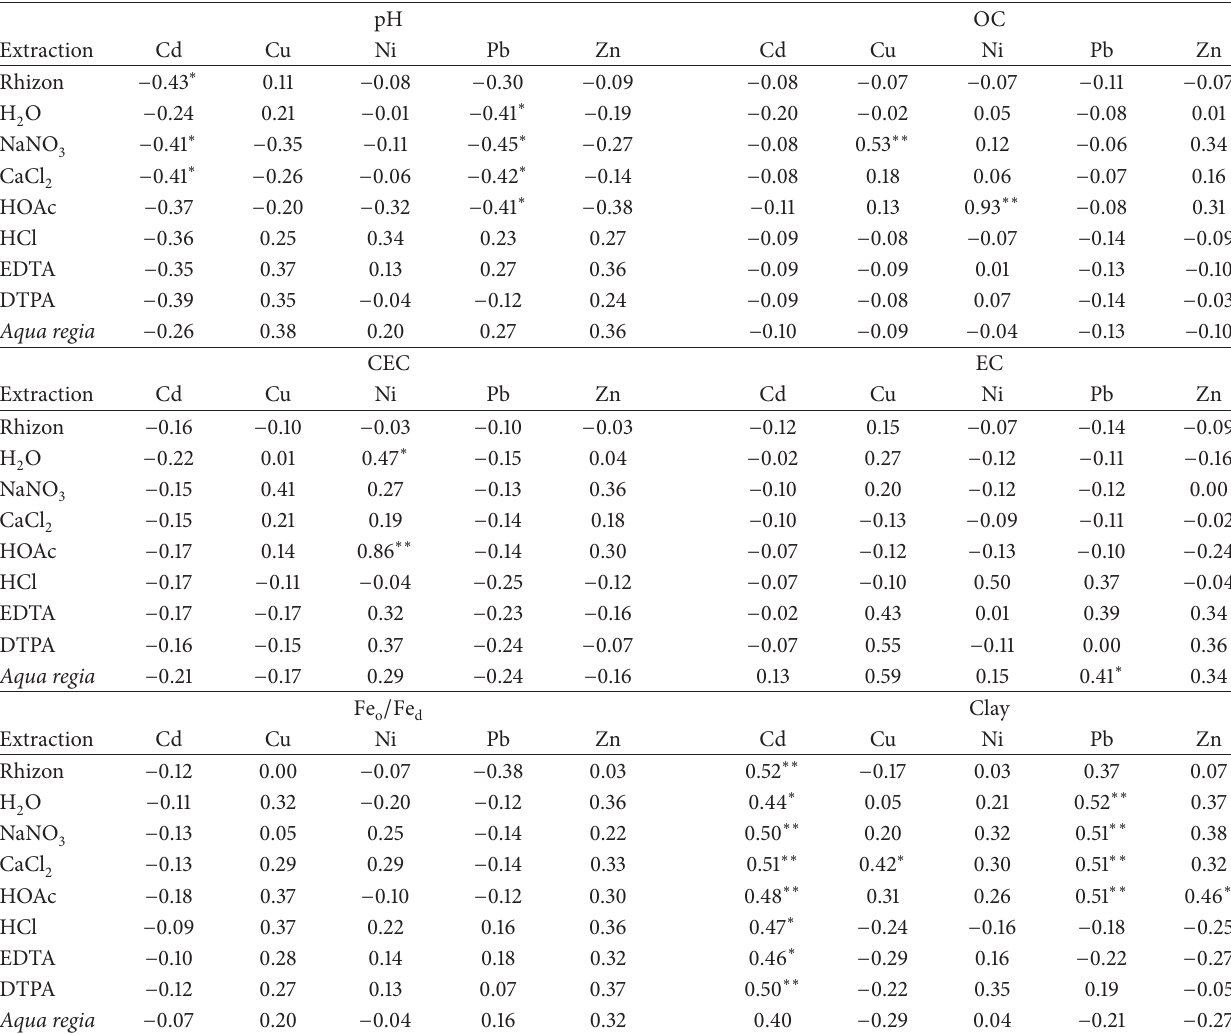
Table 7: Pearson linear correlation coefficients between extractable heavy metal concentrations and soil properties (𝑛 = 22) .